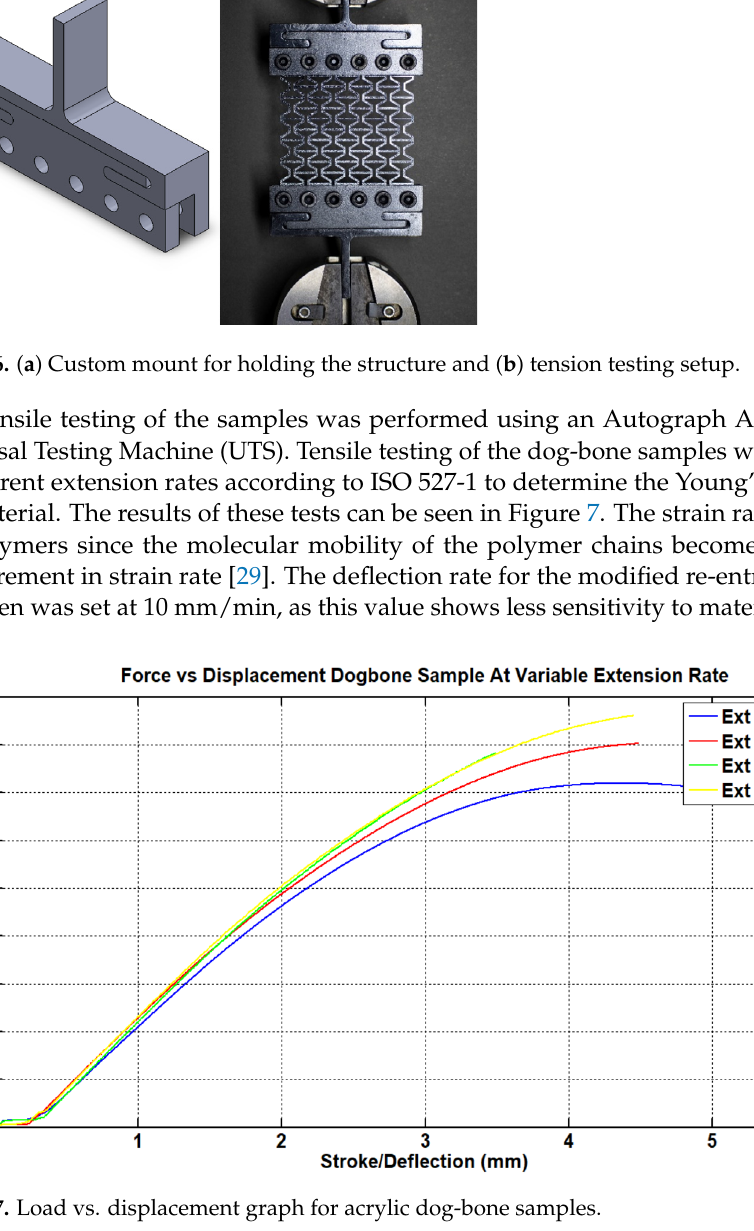
Figure 6. ( a ) Custom mount for holding the structure and ( b ) tension testing setup.